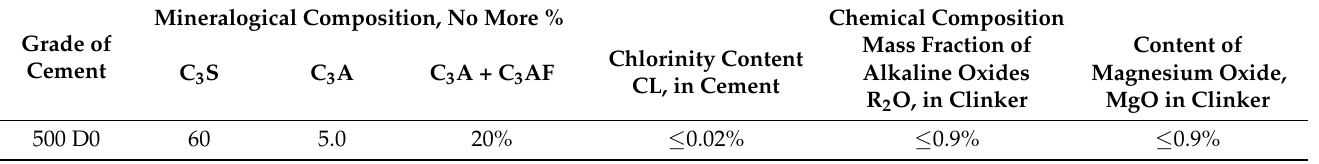
Table 2. Mineralogical and chemical composition of Portland cement 500